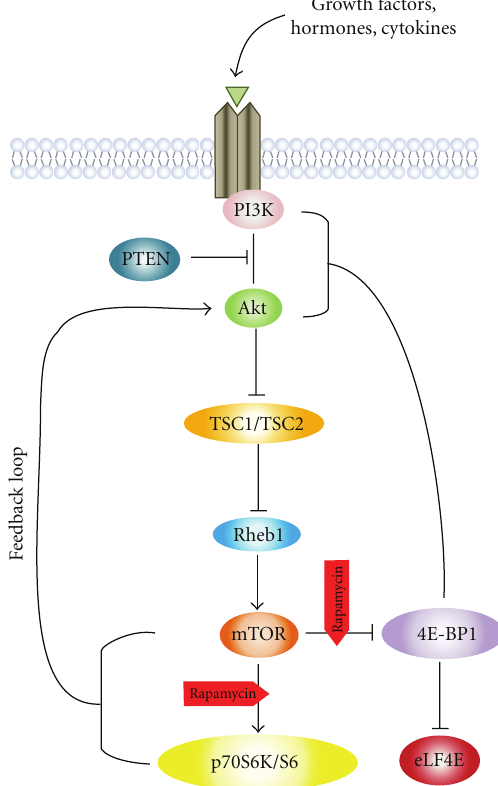
Figure 1: Schematic representation of AKT-mTOR signaling pathway showing rapamycin inhibition sites in